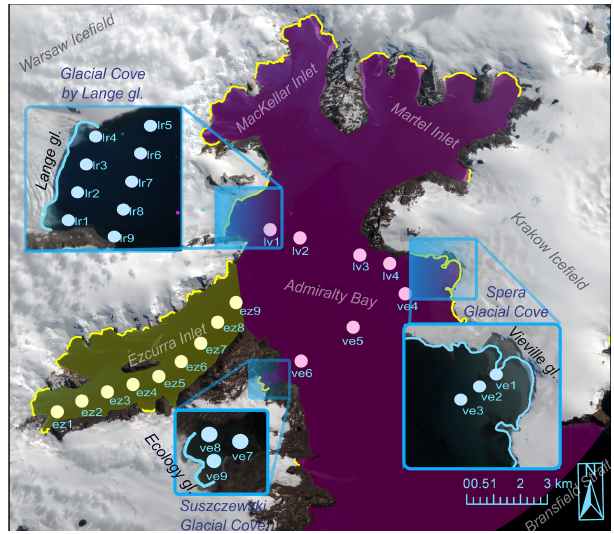
Figure 1. Map of Admiralty Bay showing the measurement points in the following three distinct zones: the main body of Admiralty Bay (pink), glacial coves (blue inset boxes) and the Ezcurra Inlet (yellow lines based upon Gerrish et al., 2021). Bright yellow de- notes the current position of the ice–water coastline, and the bright blue insets show the position of the coastline on 10 March 2018. (Sourced from Sentinel imagery, 29 December